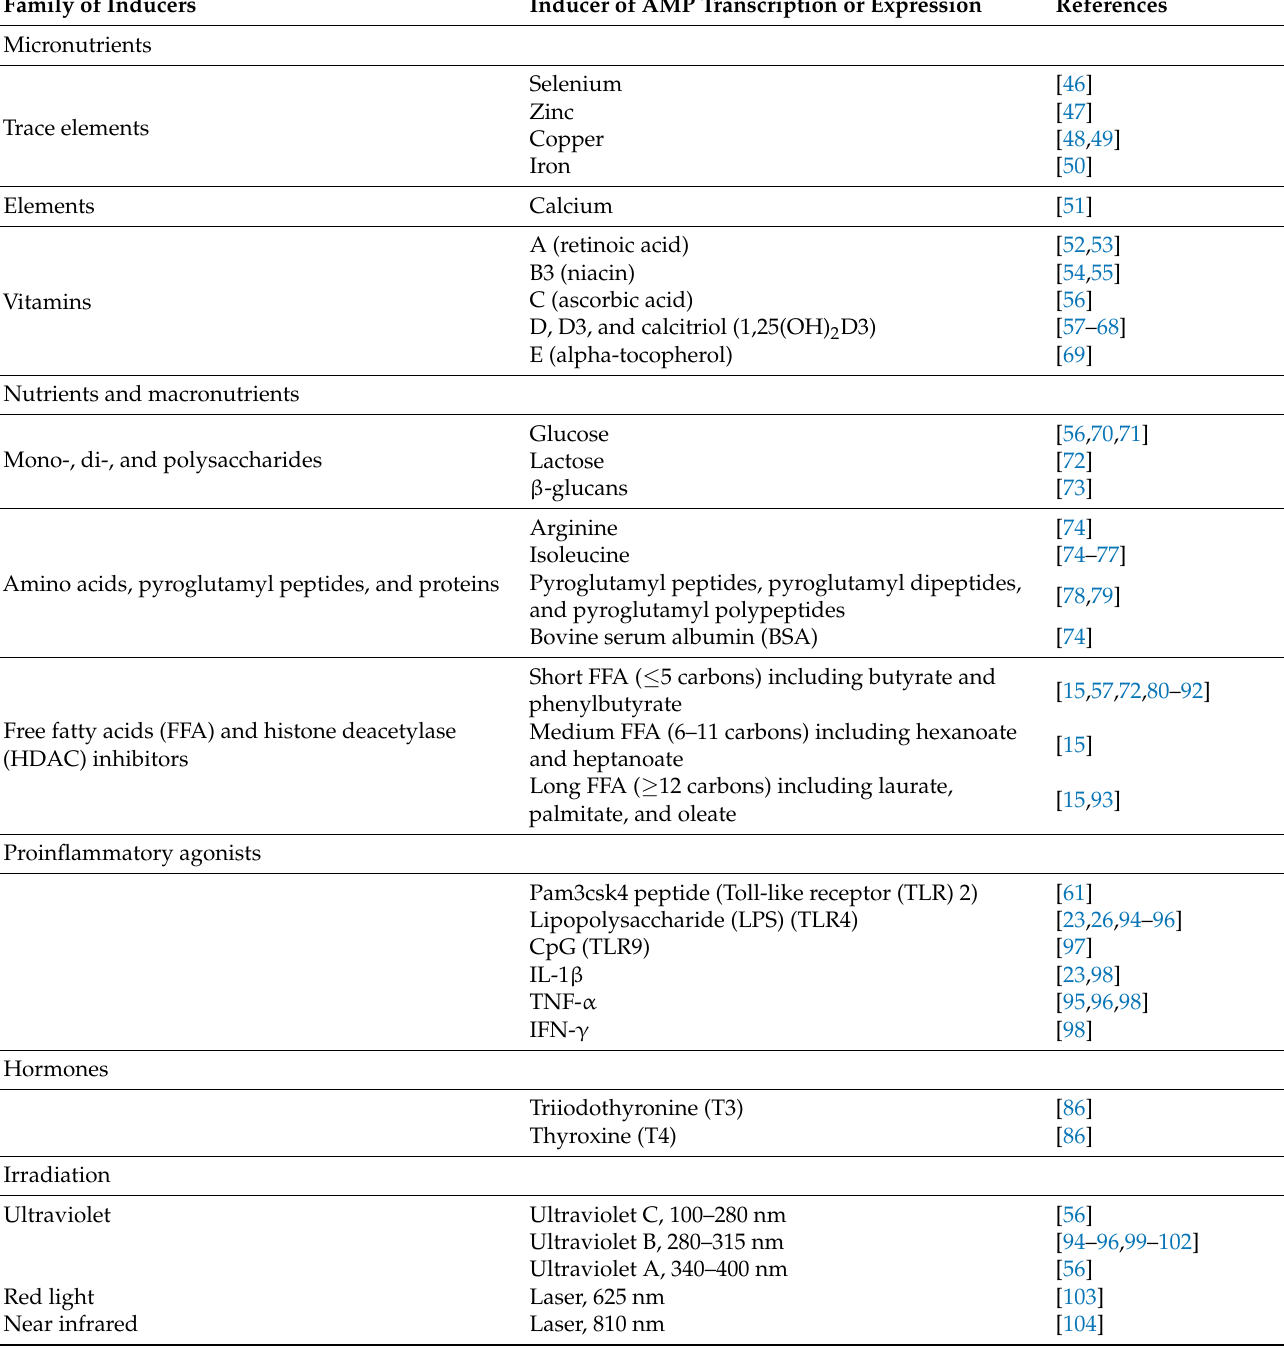
Table 1. Inducers of endogenous antimicrobial peptides (AMPs) to treat oral infection and